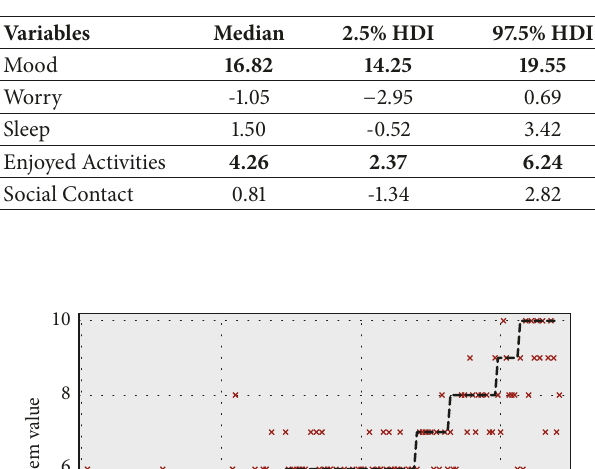
Figure 3: Graphic visualization of predicted and observed values.